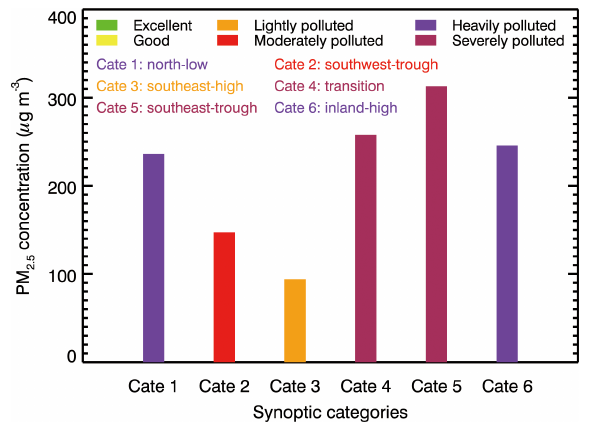
Figure 6. Daily mean PM 2 . 5 mass concentration average during the six typical synoptic situations from 2008 to 2012 at the IEECAS